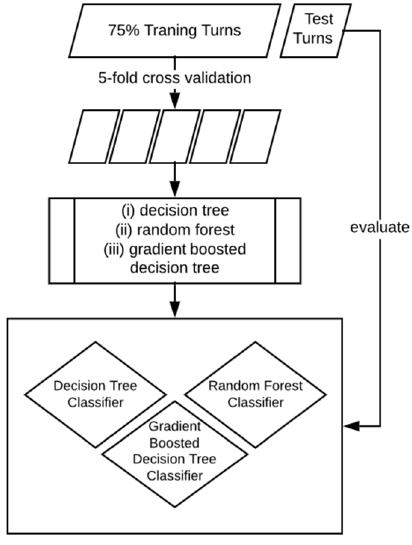
Figure 5. Training and testing data set.